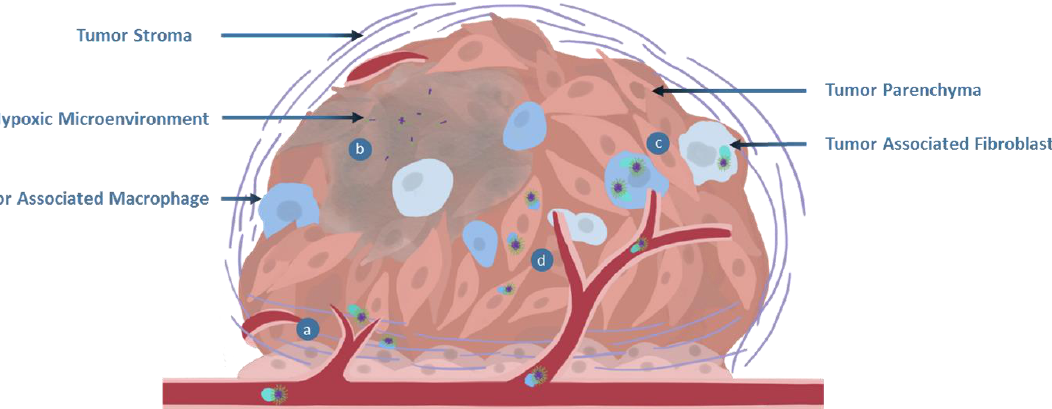
Figure 3. Obstacles associated with tumor accumulation: ( a ) Poor di ff usion through tumor stroma; ( b ) premature exposure to delivery stimulus in a hypoxic microenvironment; ( c ) uptake by tumor associated cell populations (e.g., fibroblasts); and ( d ) nanoparticle uptake only within nearby target cells rather than homogeneously throughout the malignant mass.